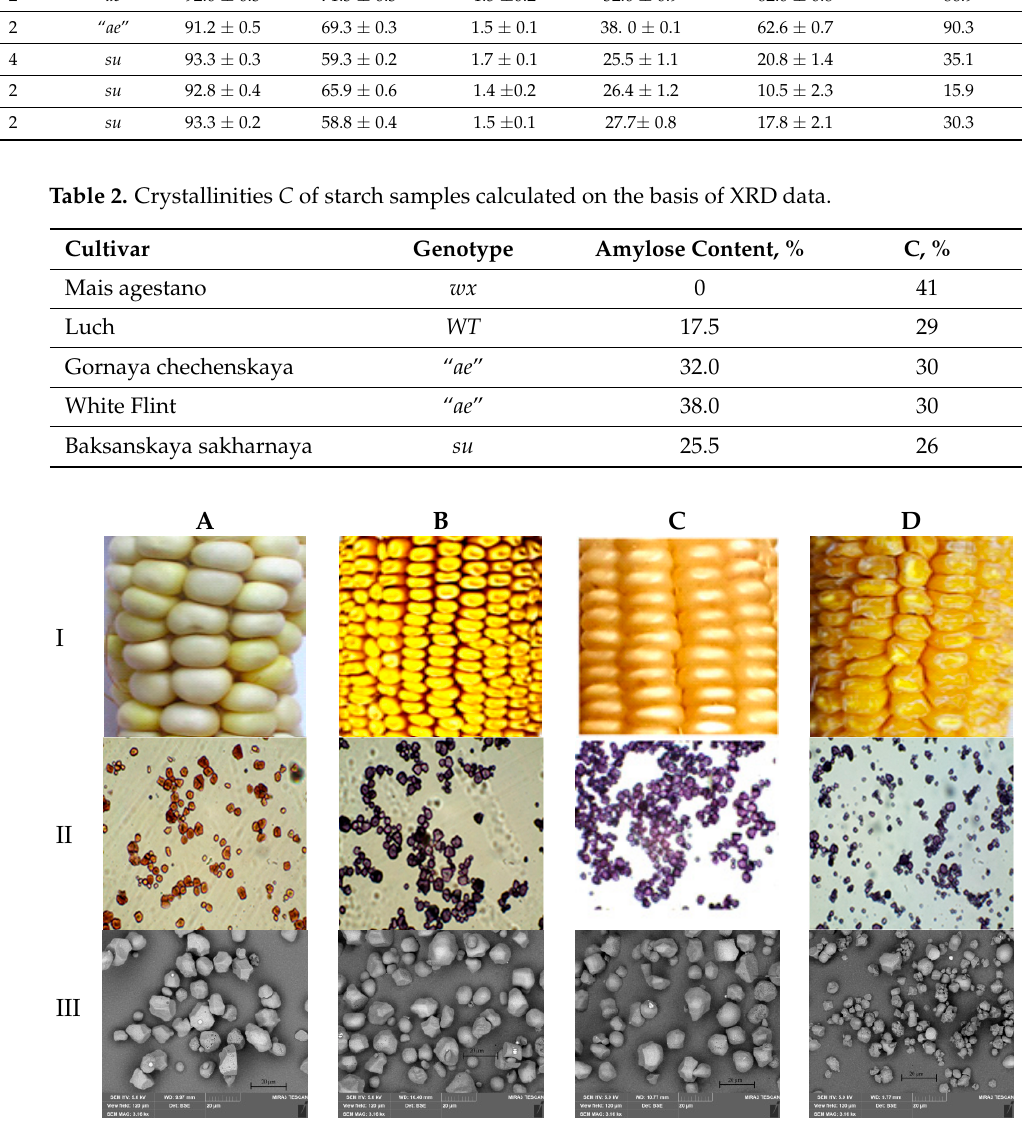
Figure 3. Examples of images of phenotypic trains in maize grain ( I ), as well as light ( II ) and electron scanning (bar = 20 μ m) ( III ) microscopies images of starch granules with different genotypes (( A ) wx , ( B ) WT, ( C ) “ ae” , ( D ) su ). Light microscopy images of starch granules stained with Lugol’s solution with a 400× zoom. Table 1. Values of the main components in the grain’s endosperm of different maize genotypes and effectiveness indicators of their processing into starch.